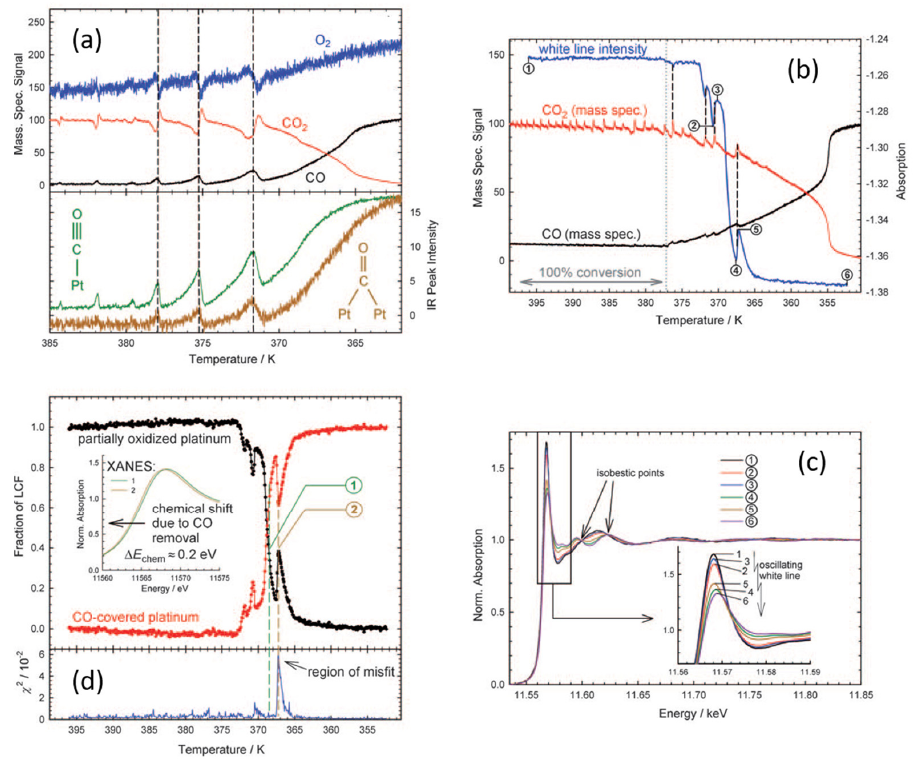
Figure 12. ( a ) Variation in O 2 , CO, and CO 2 signals observed in MS (upper panel) with infrared bands corresponding to linear and bridged CO species measured in a pellet reactor as a function of temperature. ( b ) Pt L 3 -edge white line intensity (blue) variations measure 1 mm into the in inlet of a plug flow reactor containing a 2 wt % Pt/Al 2 O 3 catalysts under a reactive CO/O 2 feed (CO/O 2 = 1:19) alongside online MS for CO (black) and CO 2 (red) as a function of temperatures. ( c ) Pt L 3 -edge XANES spectra at the points indicated (1–5) in ( b ). ( d ) The results of LCF fitting of the time resolved Pt L 3 -edge XANES obtained from the plug flow reactor experiment shown in ( c ) derived from fitting combinations due to CO covered and surface oxidized Pt spectra. Reproduced with permission from.